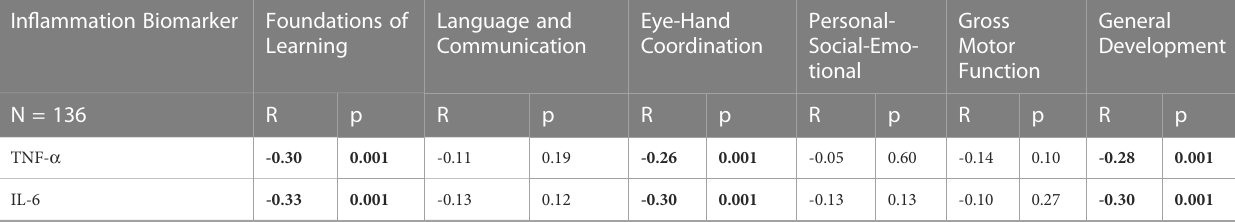
TABLE 2 Spearman Correlation analysis of in fl ammatory biomarkers and cognitive performance of preschool aged children. In fl ammation